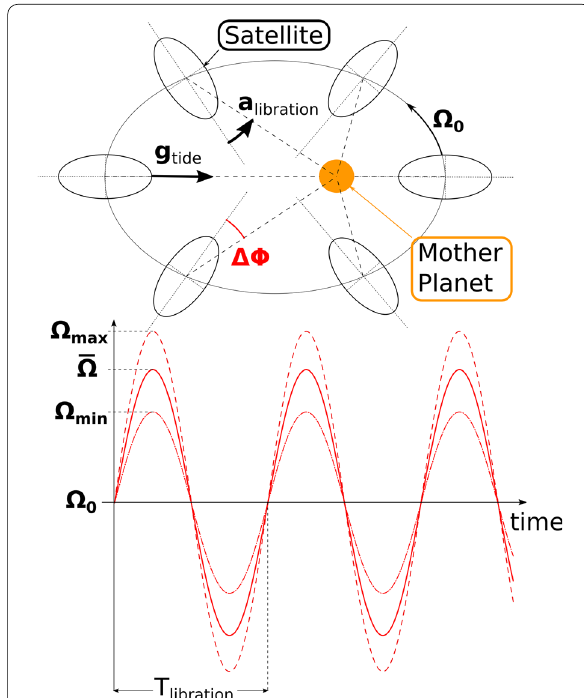
Fig. 3 Illustration of the phenomenon of forced libration and tidal acceleration (upper panel). The libration acceleration a libration leads to periodic acceleration and deceleration of the satellite’s rotation rate (cid:31) 0 , which results in the so‑called libration angle (cid:31)(cid:30) . The tidal acceleration, g tide acts between the mother planet and the satellite and leads to a deformation of the satellite’s surface. While the orbit rotation rate (cid:31) 0 generates a constant offset on the rotation rate sensor recording, the libration modulates this offset in a sinusoidal shape with a period of T libration . From existing interior models of the satellite we can constrain the minimum ( (cid:31) min ) and the maximum ( (cid:31) max ) expected libration amplitudes (lower